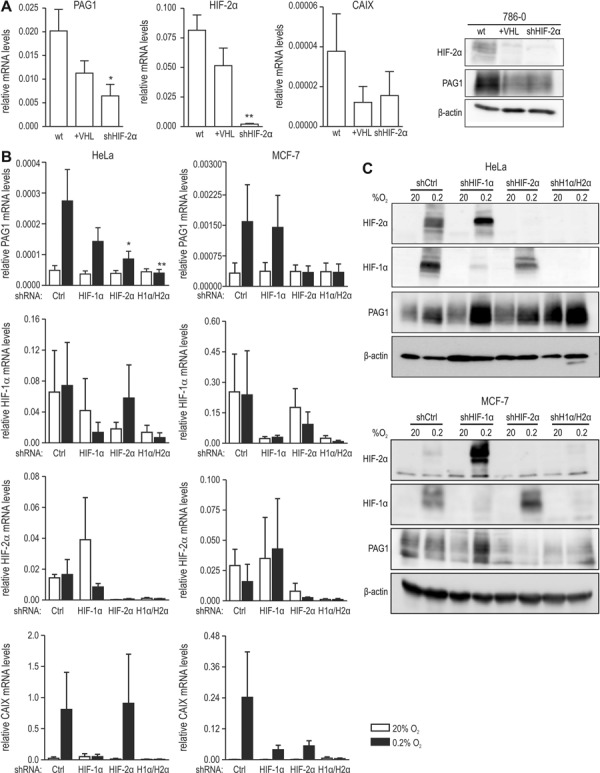
HIF-dependent PAG1 expression. (A, left panel) PAG1 mRNA levels in VHL-deficient 786–0, VHL-reconstituted 786-VHL and shHIF-2α 786–0 ccRCC cells. HIF-2α and CAIX mRNA levels were included as controls. All mRNA expression levels were determined by RT-qPCR and displayed relative to the β-actin mRNA levels (n = 3), error bars correspond to the SEM. Statistical analyses were performed with one-way ANOVA and Dunnet's correction for multiple comparisons (*P < 0.05; **P < 0.01). (A, right panel) Protein levels of HIF-2α, PAG1 and β-actin were determined by immunoblotting of 786–0 cells. (B) HeLa and MCF-7 cells were stably transfected with shCtrl, shHIF-1α and/or shHIF-2α, and exposed for 24 h to 20% O2 or 0.2% O2. PAG1, CAIX, HIF-1α and HIF-2α mRNA levels were quantified by RT-qPCR and shown relative to β-actin mRNA levels (n = 3), error bars correspond to the SEM. Statistical analyses were performed with one-way ANOVA and Dunnet's correction for multiple comparisons (*P < 0.05; **P < 0.01). (C) HeLa and MCF-7 cells were treated as in (B) and HIF-2α, HIF-1α, PAG1 and β-actin proteins detected by immunoblotting.